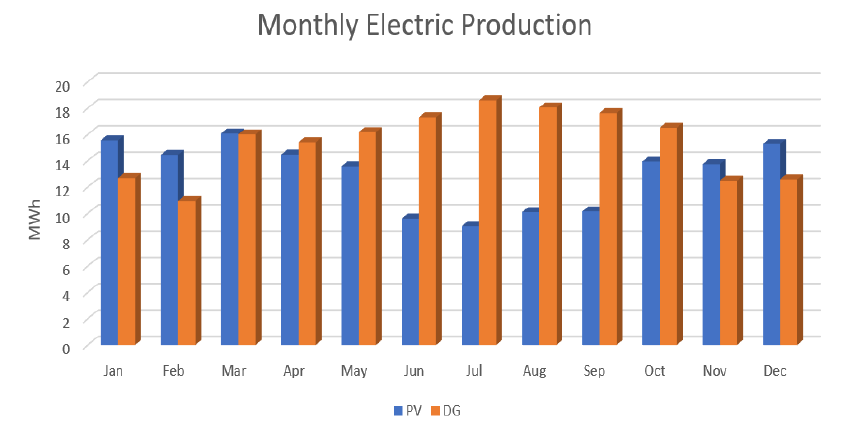
Figure 9. PV/Battery/DG-based electricity production throughout the year.